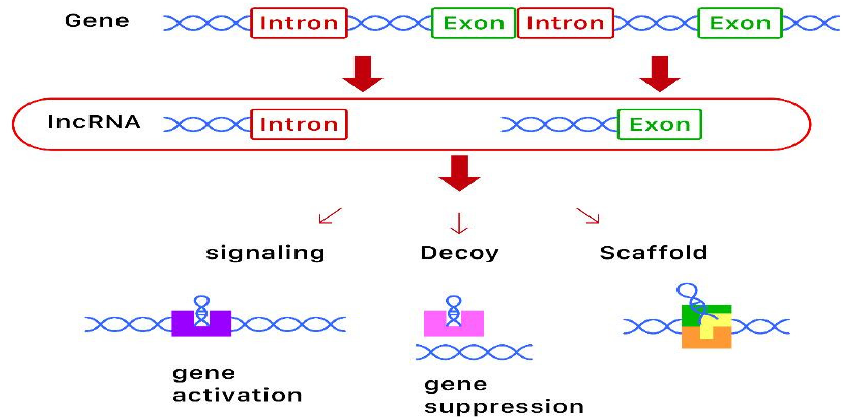
Figure 1. Diagram of the biosynthesis and function of long-non-coding RNAs (lncRNAs). lncRNAs are derived from genes, some containing introns and some containing exons. These lncRNAs then act as signaling (for gene activation), decoy (for gene suppression), or scaffold molecules to exert epigenetic modification.